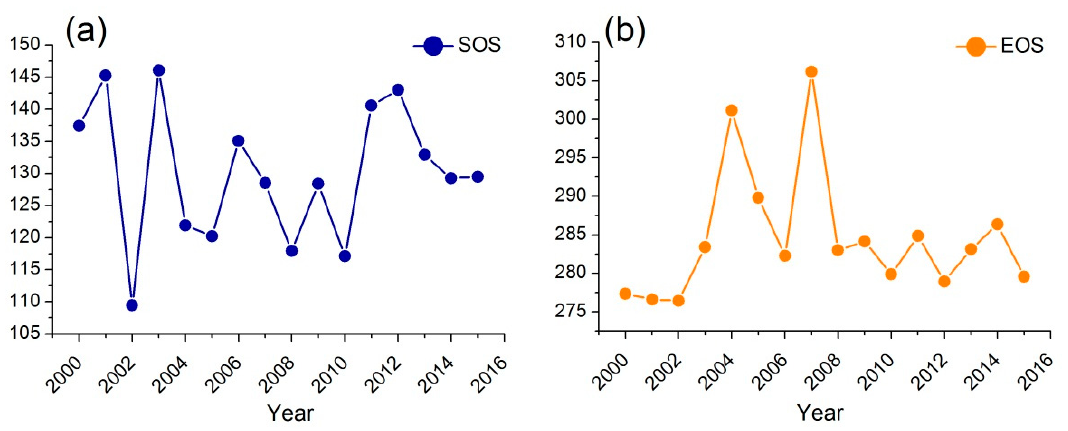
Figure 5. Mean values of interannual variability in ( a ) the start of the growing season (SOS) and ( b ) the end of the growing season (EOS) in the whole study area.